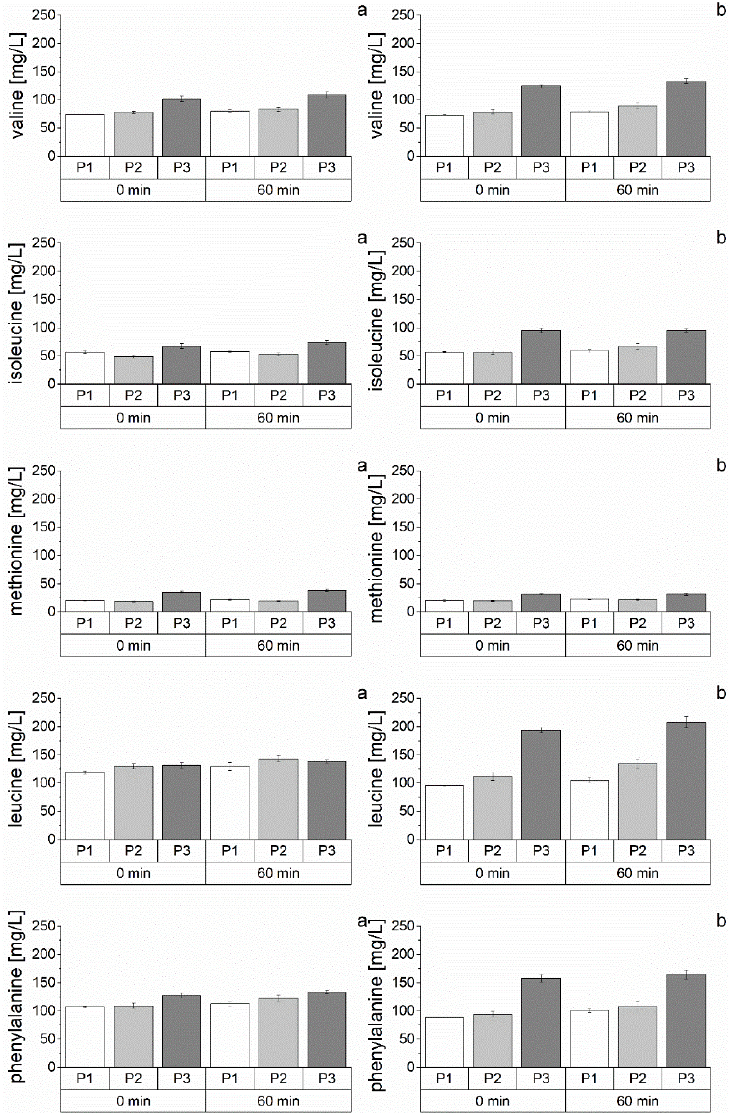
Figure 2. Concentration of selected amino acids at the start (0 min) and end (60 min) of boiling at different malt modification levels (P1 < P2 < P3; n = 3); ( a ) = B1; ( b ) = B2.